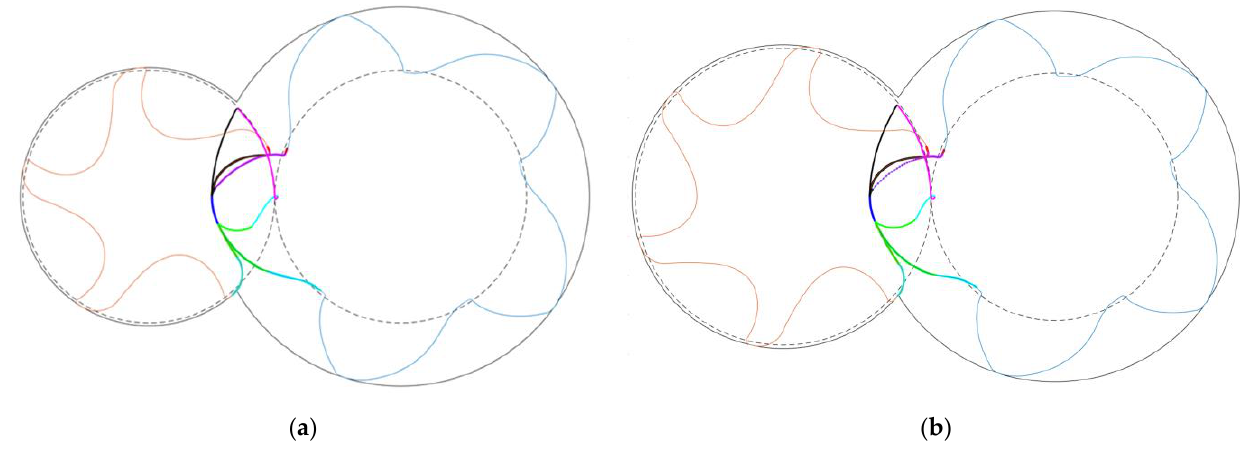
Figure 5. Rotor profiles: ( a ) rotor profile of low-pressure stage; ( b ) rotor profile of high-pressure stage.